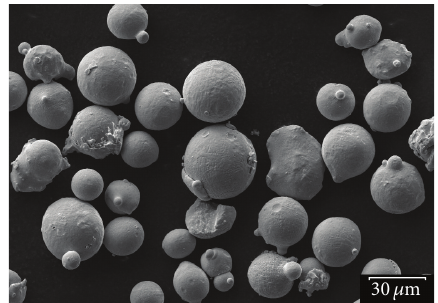
Figure 1: Morphology of the used CoNiCrAlY powder.